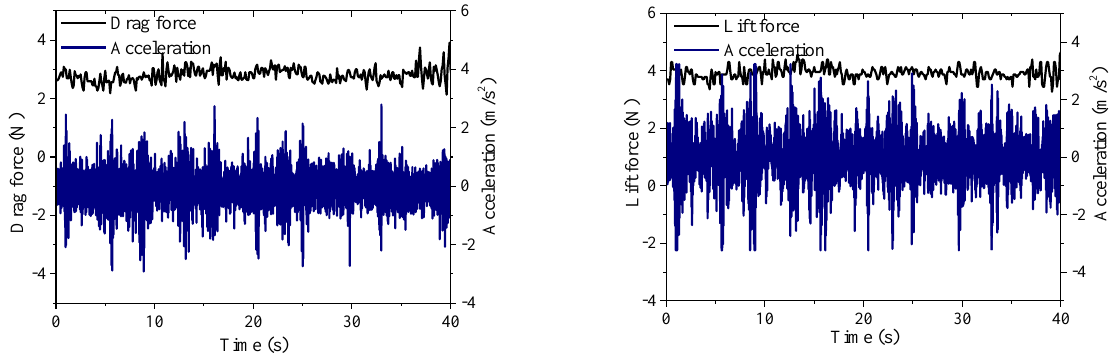
Figure 9. Time histories of aerodynamic forces (at wind attack angle of 30 ◦ ) and vibration accelerations in the corresponding direction, with test conditions of viaduct highway and no end plates.